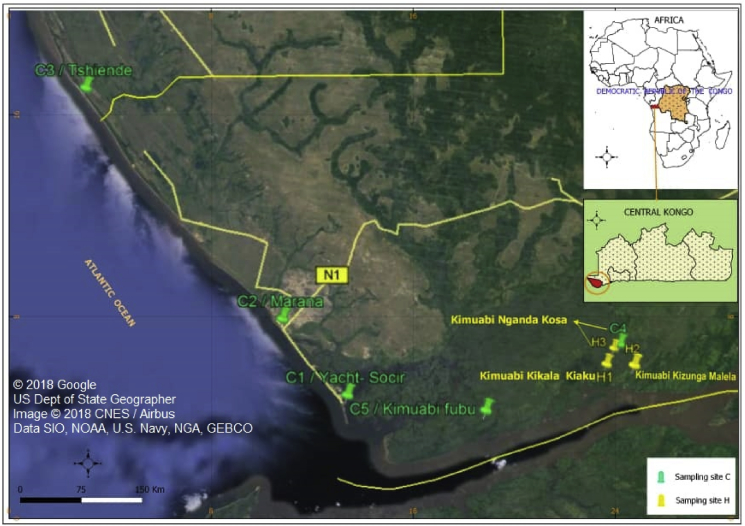
Map of the sampling location indicating: Location of Congo DR in Africa; Location of territory of Muanda in Congo DR; Atlantic Coast of Muanda in Central Congo Province, sampling stations (Adapted from Google Earth).